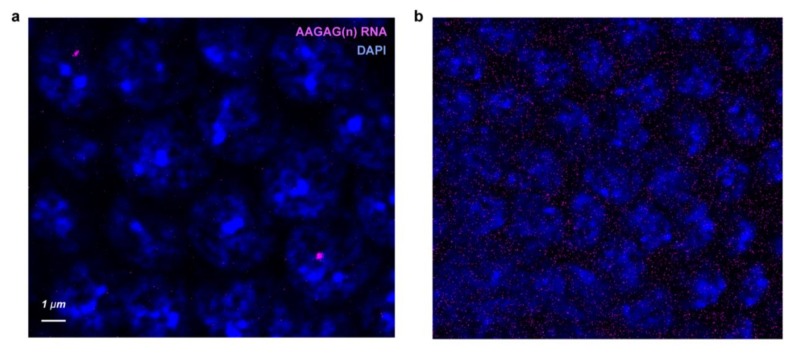
AAGAG RNA-FISH localizes RNA and not DNA.Confocal sections of cycle 14 nuclei treated with either (a) RNAseH or (b) RNAseIII after AAGAG RNA probe (magenta) hybridization. A higher laser intensity for the AAGAG probe channel was used in b to demonstrate abolishment of AAGAG signal.